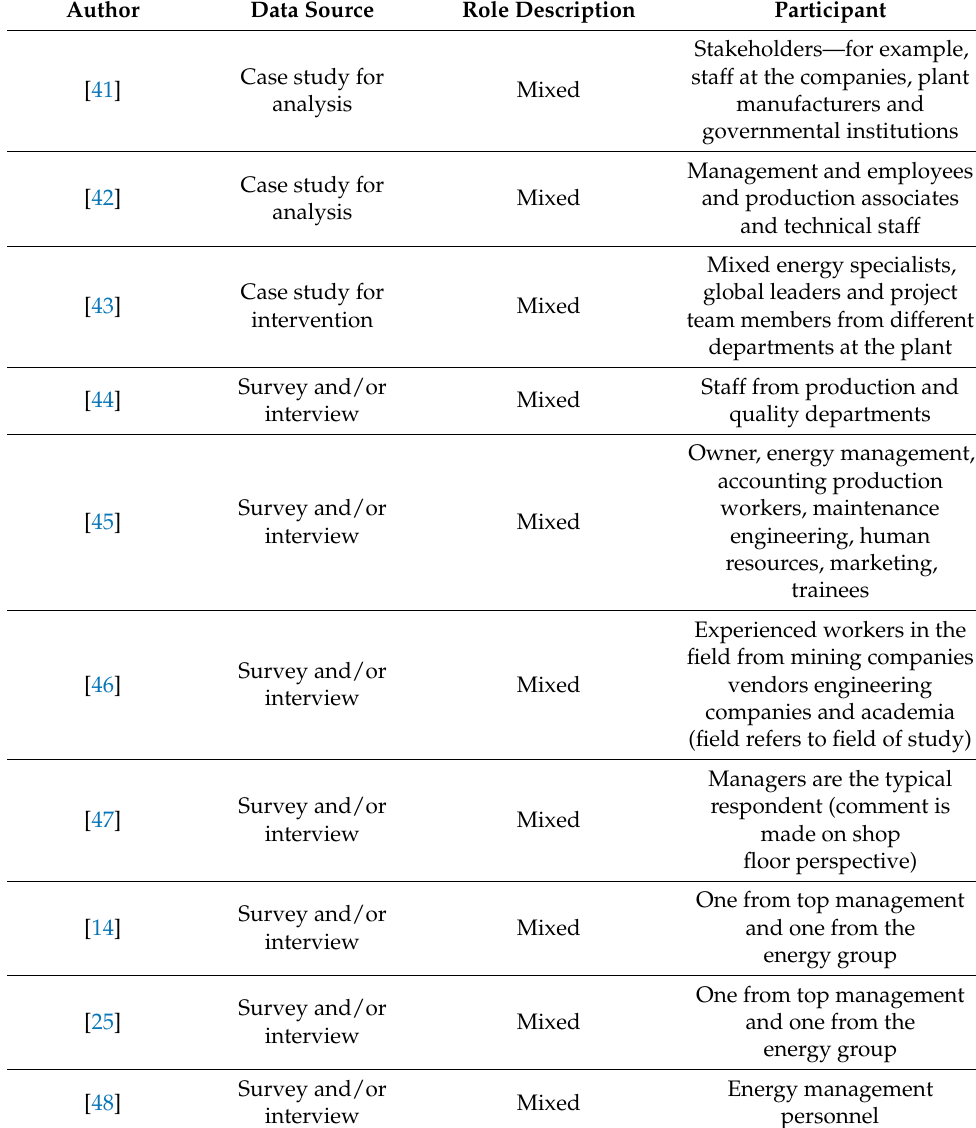
Table 2. Participant descriptions for studies where the role description was coded as mixed. Entries where frontline workers are included have been